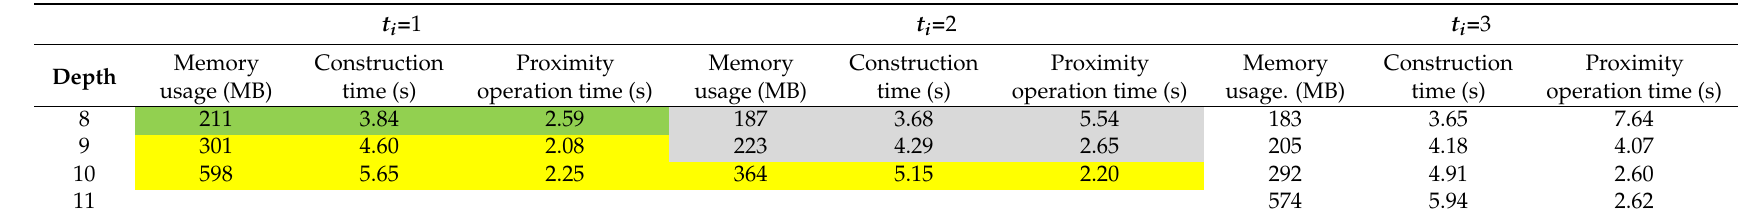
Table 11. Performance comparison among isometric octree groups using Data 2.